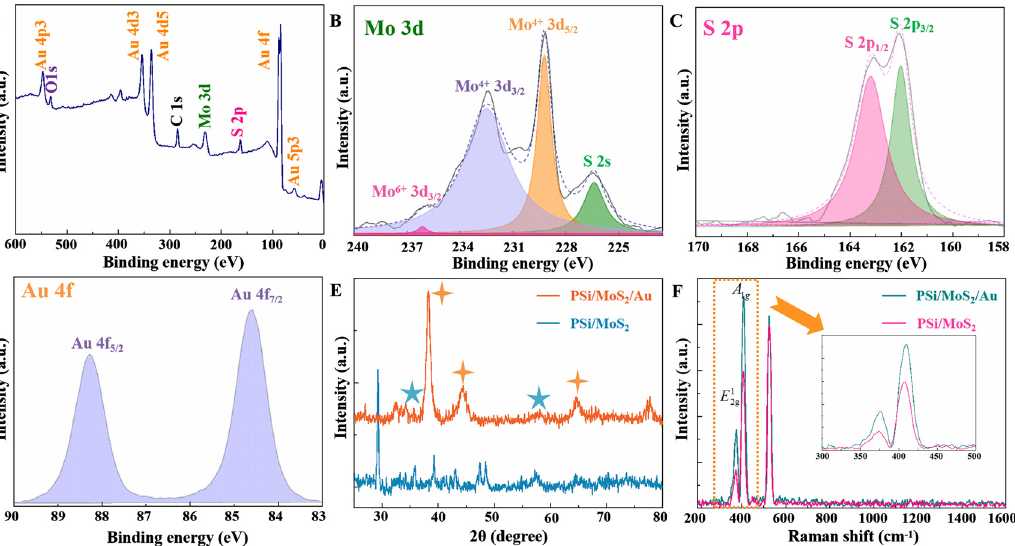
Figure2: X-rayphotoelectronspectroscopy(XPS),X-raydiffraction(XRD),andcorrespondinglysurface-enhancedRamanspectroscopy(SERS) comparison. XPS spectra in (A) survey, (B) Mo 3d, (C) S 2p, and (D) Au 4f regions of pyramid Si (PSi)/ molybdenum disul fi de (MoS 2 )/Au multiscale cavity (MSC) substrates. (E) XRD patterns of different samples: PSi/MoS 2 , and PSi/MoS 2 /Au. (F) SERS spectra of MoS 2 on PSi/MoS 2 MSC and PSi/ MoS 2 /Au MSC